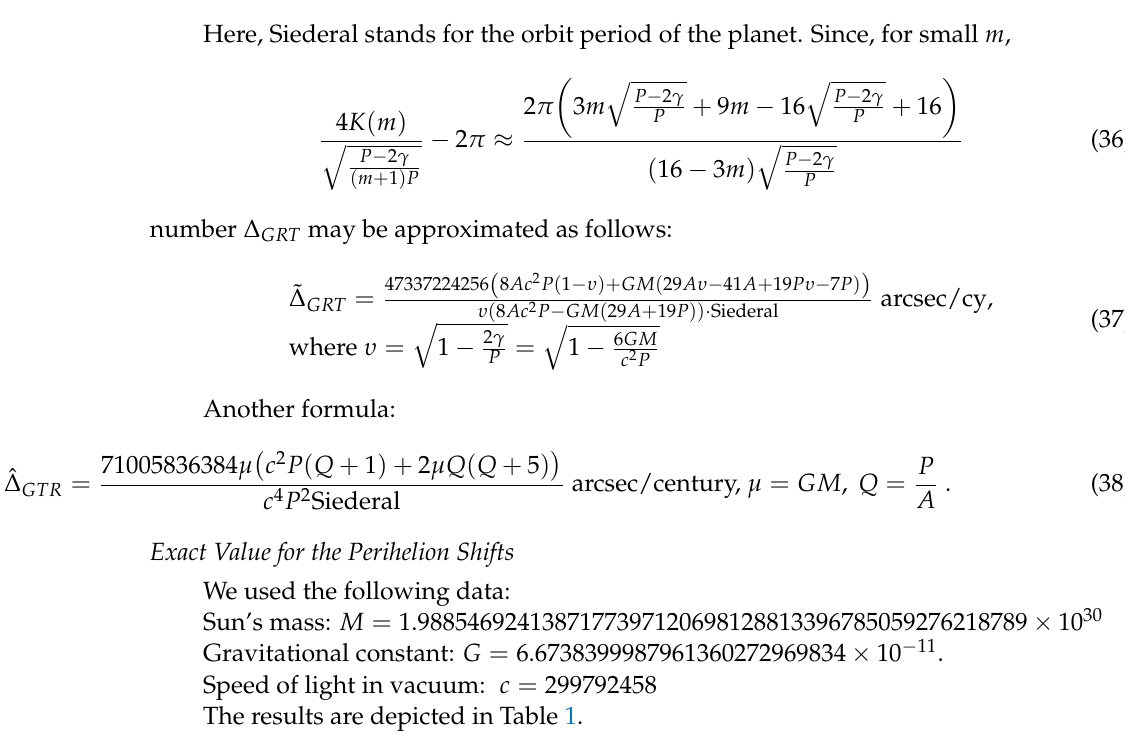
Table 1. Exact and approximate values for perihelion